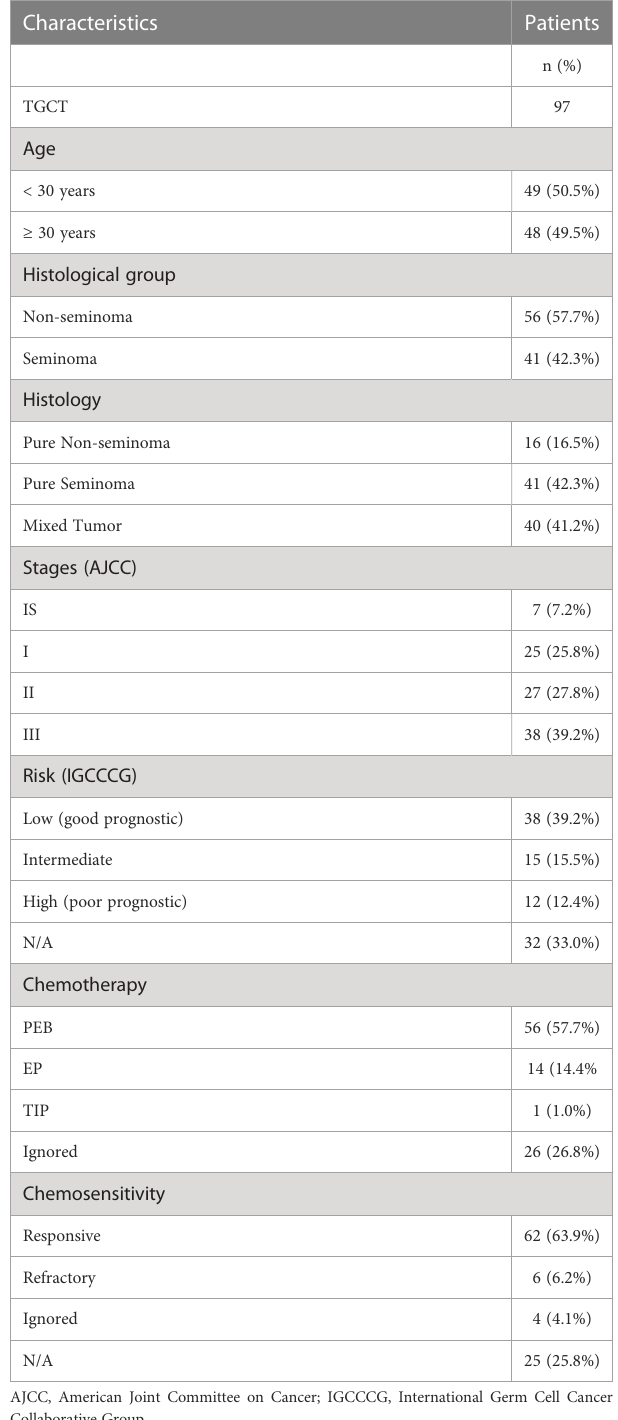
TABLE 1 Characteristics of patients with TGCT at the Barretos Cancer